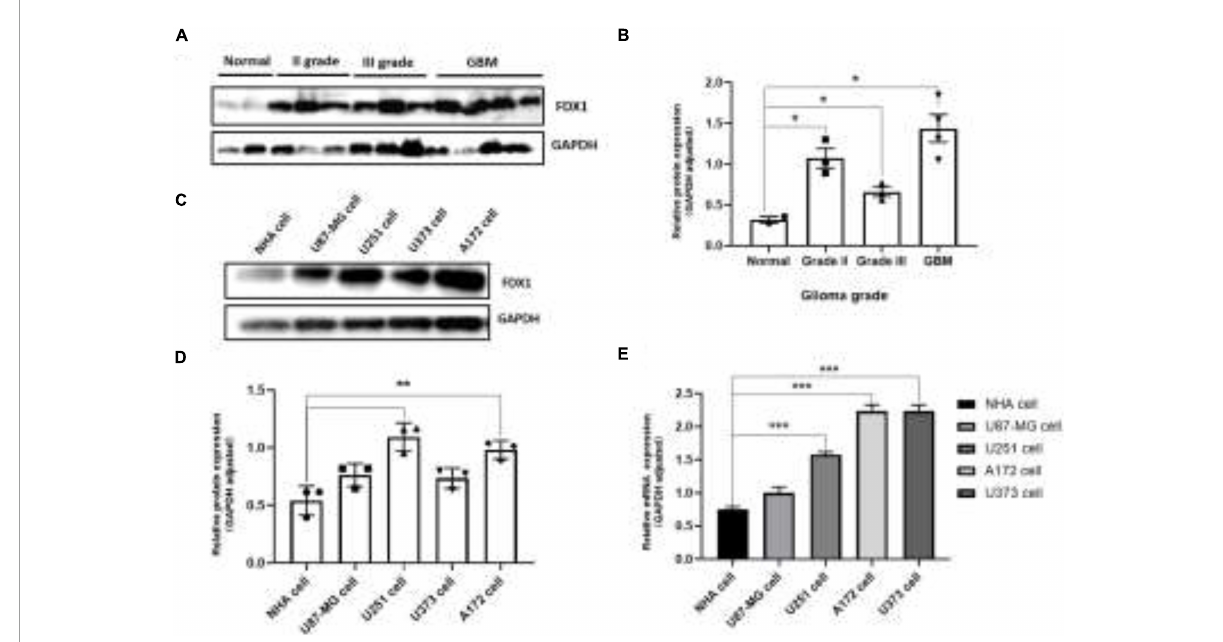
FIGURE3 Expression level analysis of FDX1 in glioma tissue glioma cell lines. (A) Expression of FDX1 protein in Normal and glioma tumor tissue (Grade II, Grade III, and GBM). (B) Statistical analysis of FDX1 protein relative to GAPDH gene expression in normal tissues and glioma tissues. (C) Expression of FDX1 protein in normal glial cell line (NHA cell) and glioma cell lines (U87-MG cell, U251 cell, U373 cell, and A172 cell). (D) Statistical analysis of FDX1 relative to GAPDH gene expression J in glia cell line and glioma cell lines. (E) mRNA expression of FDX1 gene in normal glial cell (NHA cell) and glioma cell lines. (* P ≤ 0.05, ** P ≤ 0.01, and *** P ≤ 0.001).